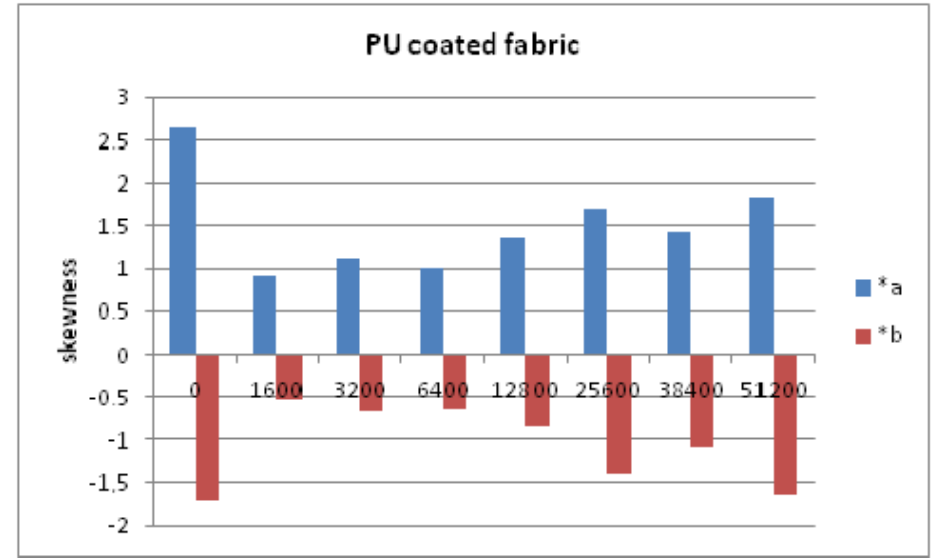
Figure 6. Skewness graph—Fabric